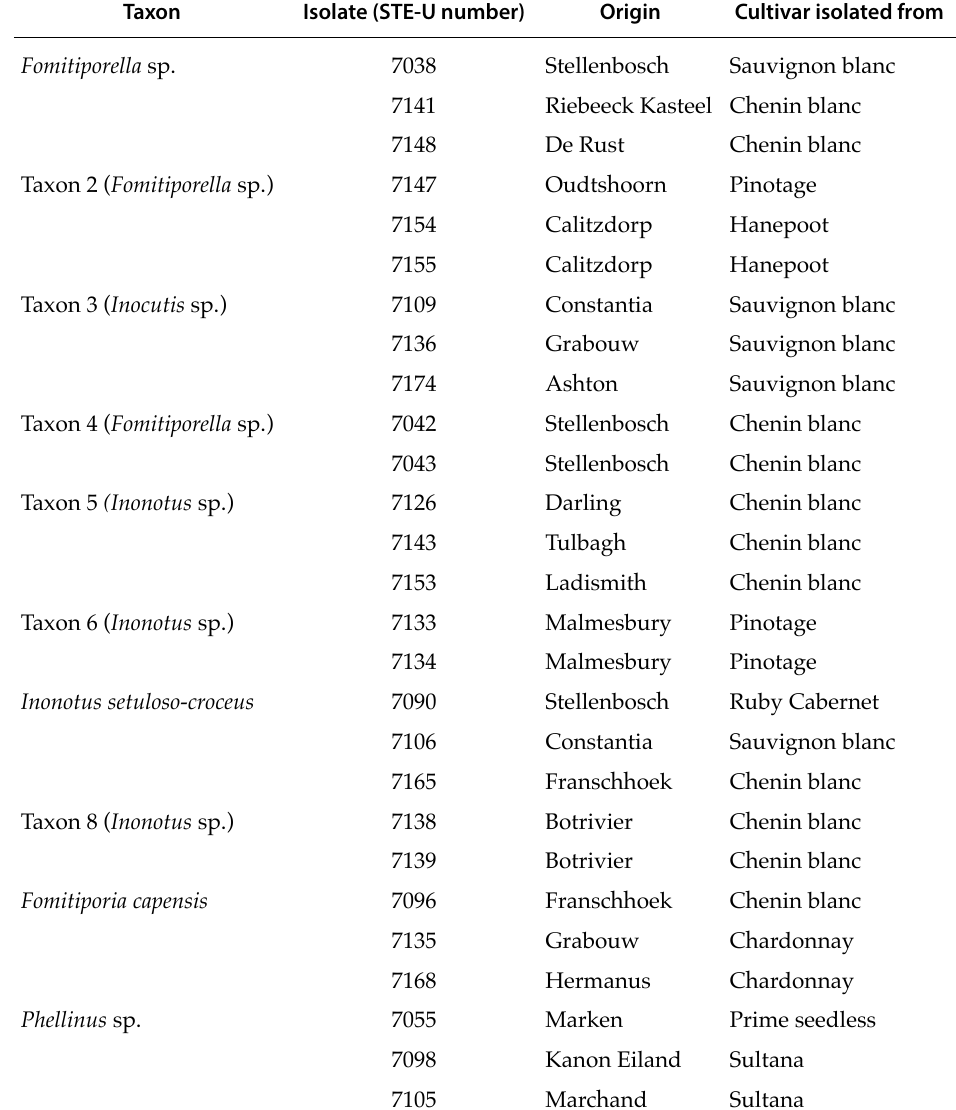
Table 1. Hymenochaetales isolates from White et al. (2011a) used in a pathogenicity study conducted on 10-year-old vines between September 2010 and November 2012 in Stellenbosch. Taxon Isolate (STE-U number) Origin Cultivar isolated from Fomitiporella